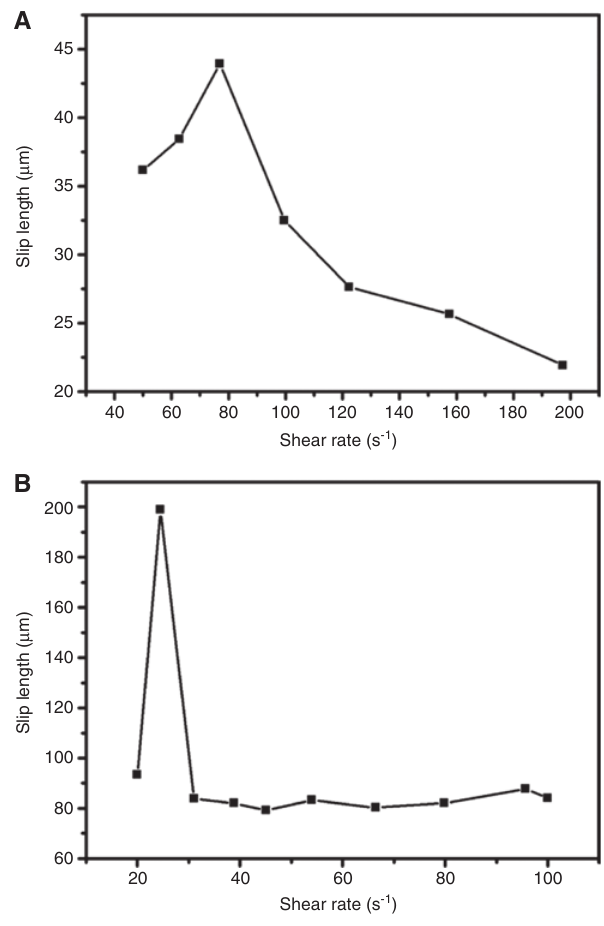
Figure 9: The slip length on superhydrophobic film comprising CNTs and fluoropolymers using (A) distilled water and (B)